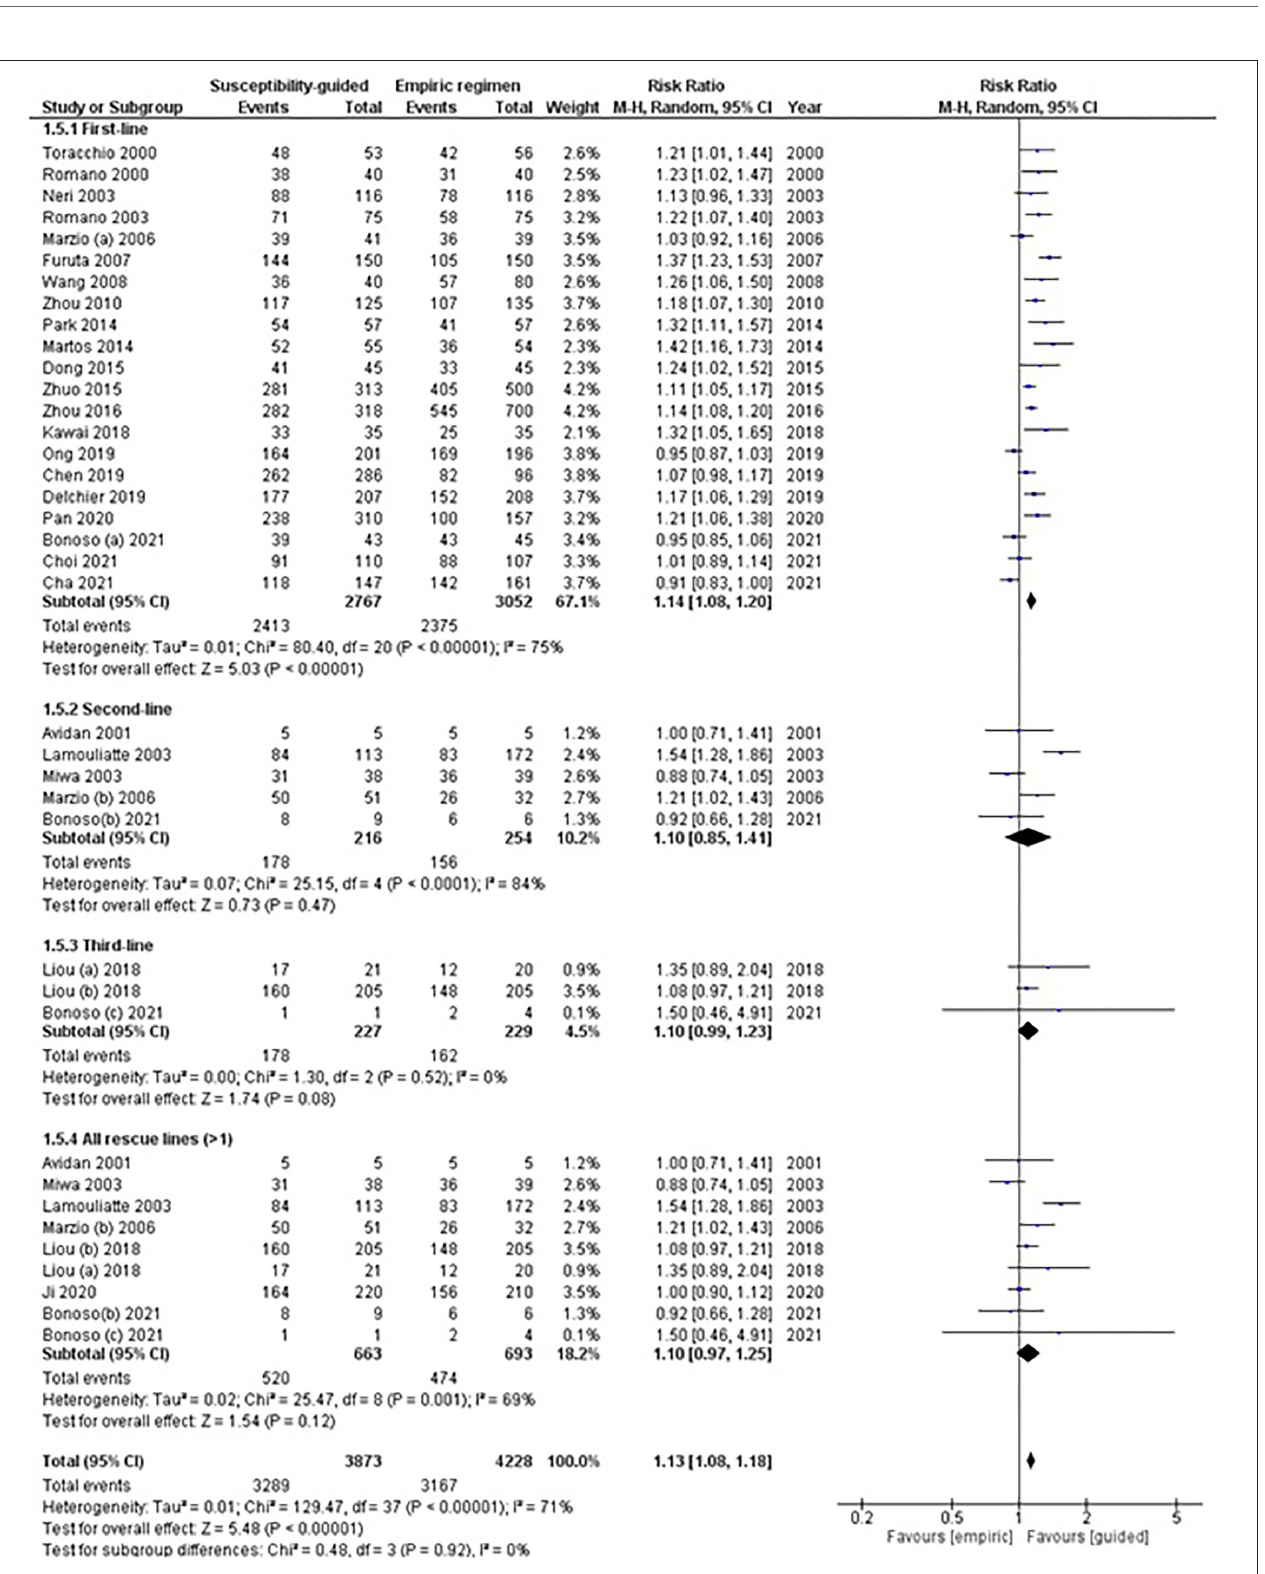
FIGURE 2 | Forest plot of randomized controlled studies comparing the effectiveness of susceptibility-guided and empirical treatment according to treatment line. M-H, Mantel–Haenszel; CI, confidence interval.